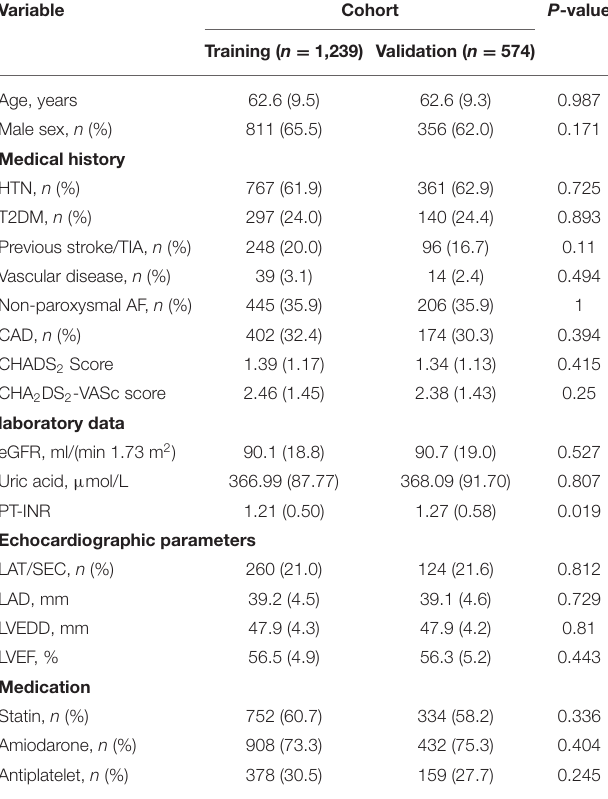
TABLE 1 | Baseline characteristics.